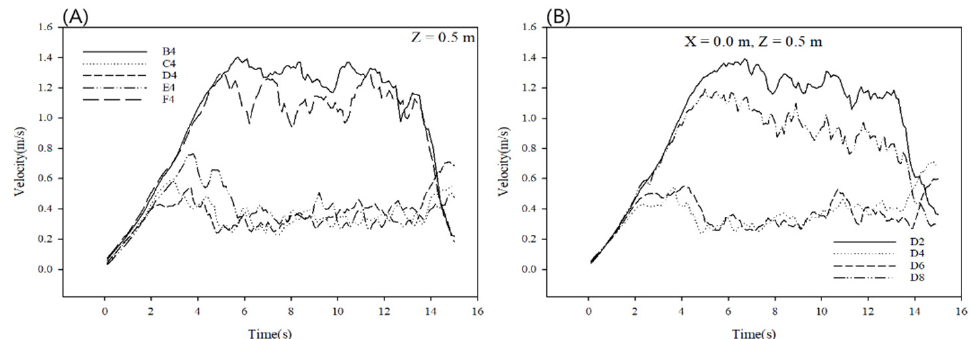
Figure 9. Results obtained at the 4th height position; ( A ) results for the mannequin at the fourth